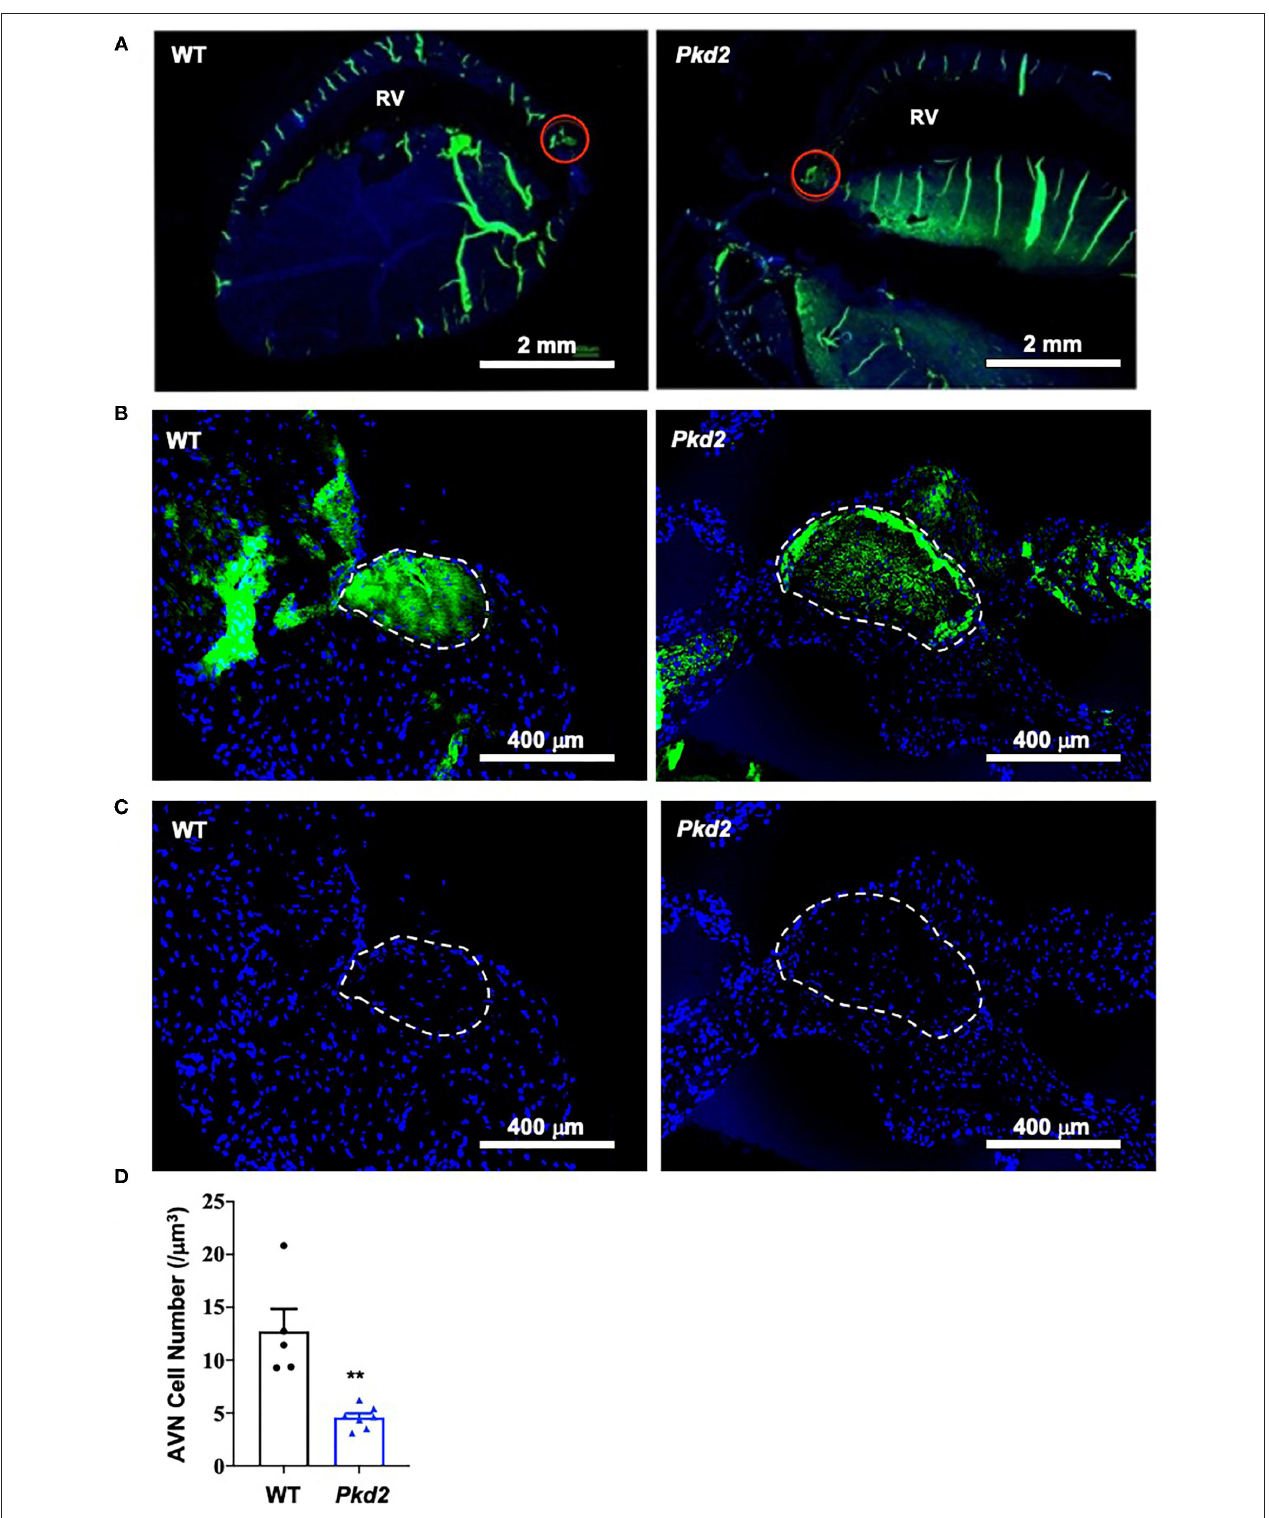
FIGURE 3 | Cell number is decreased in Pkd2 -KO mouse atrioventricular node. (A) Heart tissues were stained with anti-HCN4 antibody used as a marker for the myocardial conduction system (green staining). Atrioventricular node (AVN) is identified by both location and HCN4-postive staining indicated by the red circles; RV, right ventricle. (B) The AVN is next identified as region of interest. (C) Number of cell nucleus (DAPI; blue staining) is counted. (D) Data reveal a significantly lower number of cells in AVN of Pkd2 -KO mouse hearts. N = 5 mice for each WT and Pkd2 -KO group at age matched of 6 months old. ** p < 0.01.